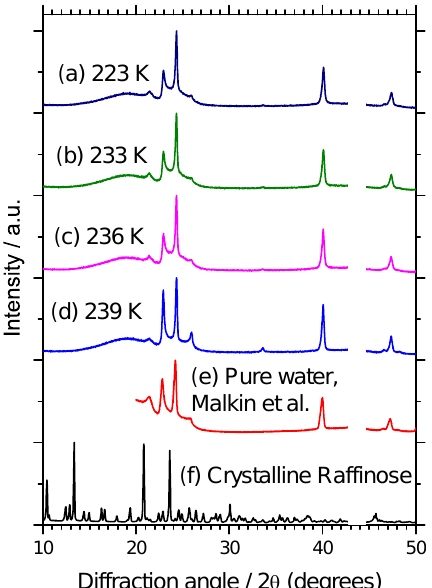
Fig. 16. X-ray diffraction patterns of frozen aqueous raffinose droplets. These 15wt% raffinose in water droplets were on the or- der of 10µm and suspended in an oil emulsion. The emulsion was cooled at a rate of 30Kmin − 1 to 223K where diffraction pattern (a) was recorded. Diffraction patterns (b) to (d) were recorded after warming the emulsion to successively greater temperatures as indi- cated in the plot. The diffraction pattern of ice which resulted from the freezing of pure water droplets (resulting in the newly identi- fied stacking disordered ice, ice I sd ) is also shown as (e) (Malkin et al., 2012). The diffraction pattern of a powder sample of crystalline raffinose measured on the same instrument is included as (f)